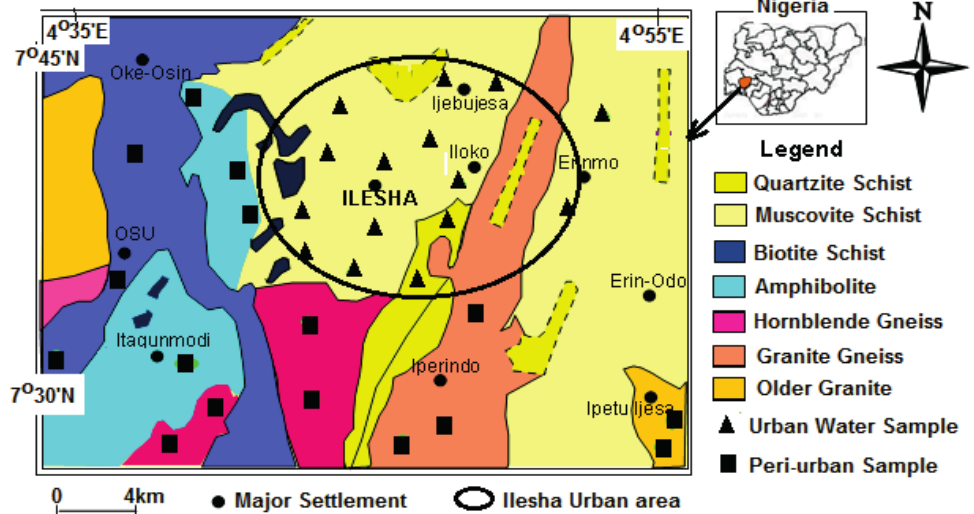
Fig. 1 Geological map of the Ilesha area showing sampling